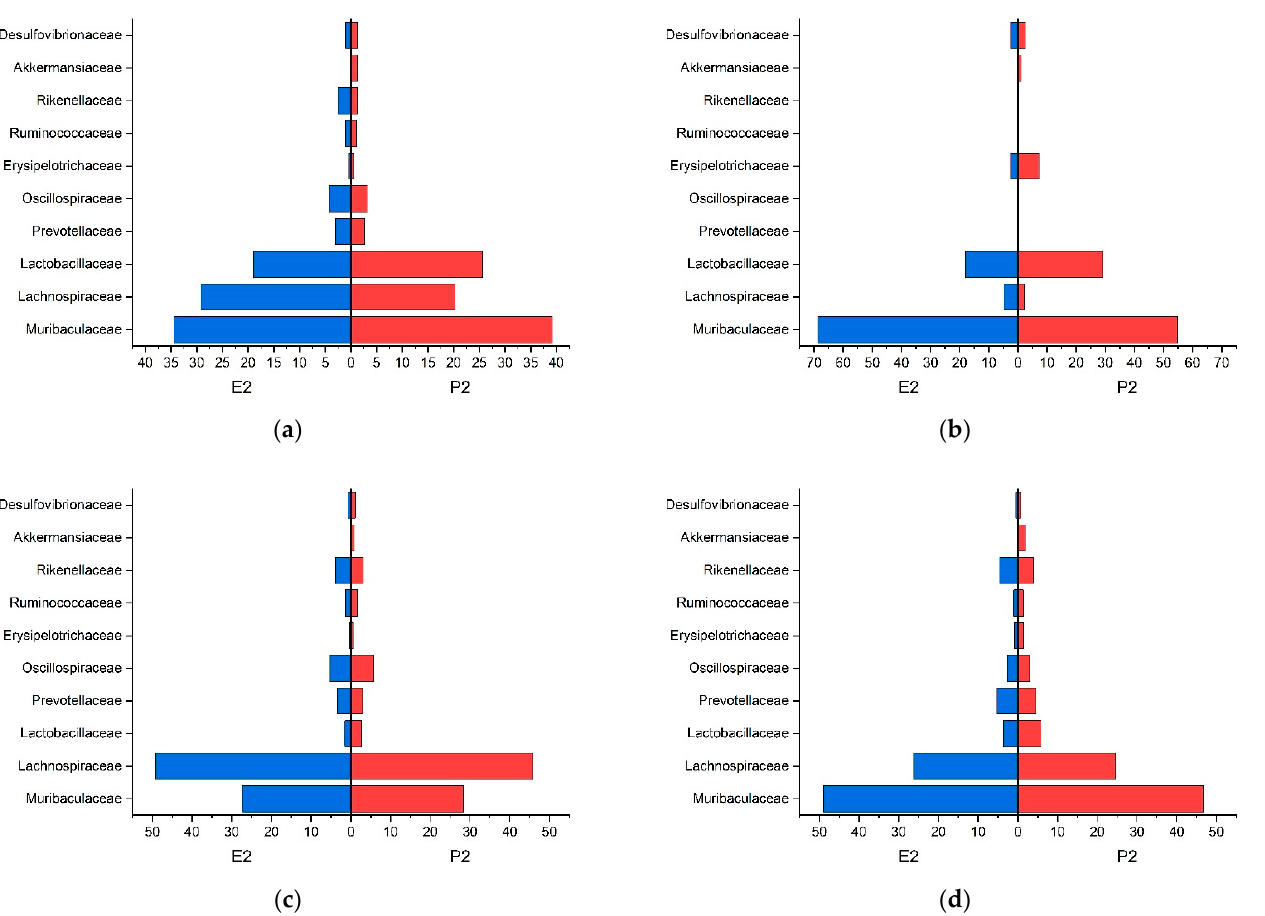
Figure 5. Population pyramid of abundant families of trial 2 given in relative abundance (percent) ( a ) stomach; ( b ) small intestine; ( c ) cecum; ( d ) colon.